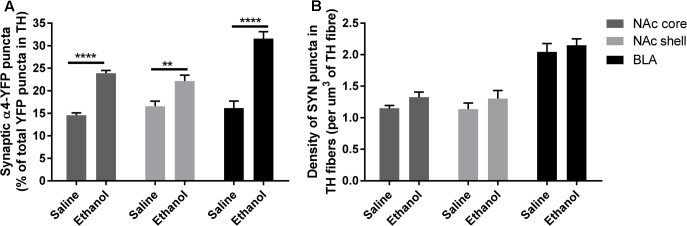
Acute ethanol exposure significantly increases the proportion of synaptic α4-YFP puncta co-localised with the marker of presynaptic boutons, synaptophysin, within TH-imunoreactive terminals in the nucleus accumbens and basolateral amygdala. (A) Effect of acute ethanol on the co-localisation of YFP puncta with synaptophysin puncta within TH immunoreactive axons in the NAc core, shell and BLA. Data are presented as a proportion of YFP puncta co-localised with synaptophysin (SYN) puncta in TH fibres, as a percent of total YFP puncta in TH fibres ± SEM (Two-way ANOVA, followed by Sidak post hoc analysis, ∗∗∗p = 0.0003; ∗∗∗∗p < 0.0001; compared to saline). (B) Effect of acute ethanol on the density of synaptophysin puncta within TH-immunoreactive fibres. Data are presented as mean density of SYN puncta per μm3 of TH reconstructed fibres ± SEM (Two-way ANOVA, followed by Sidak post hoc analysis, non-significant).